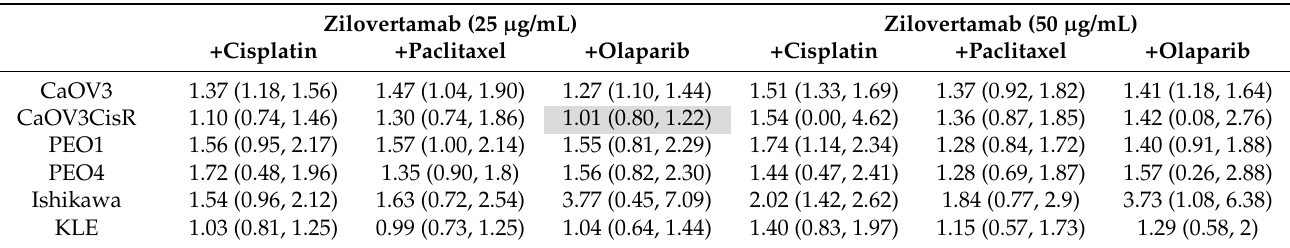
Table 2. Analysis of interaction between zilovertamab at 25 and 50 µ g/mL doses and standard chemotherapy drugs at IC70 doses (as shown in Table 1) in high-grade serous ovarian cancer and endometrial cancer cell lines at 72 h. Survival index (SI) ratio listed in the table indicated synergistic (<0.8), subadditive (>1.2) or additive (0.8–1.2, grey shaded) effect of the drug combination. Data are presented as the mean (lower 95% confidence interval, upper 95% confidence